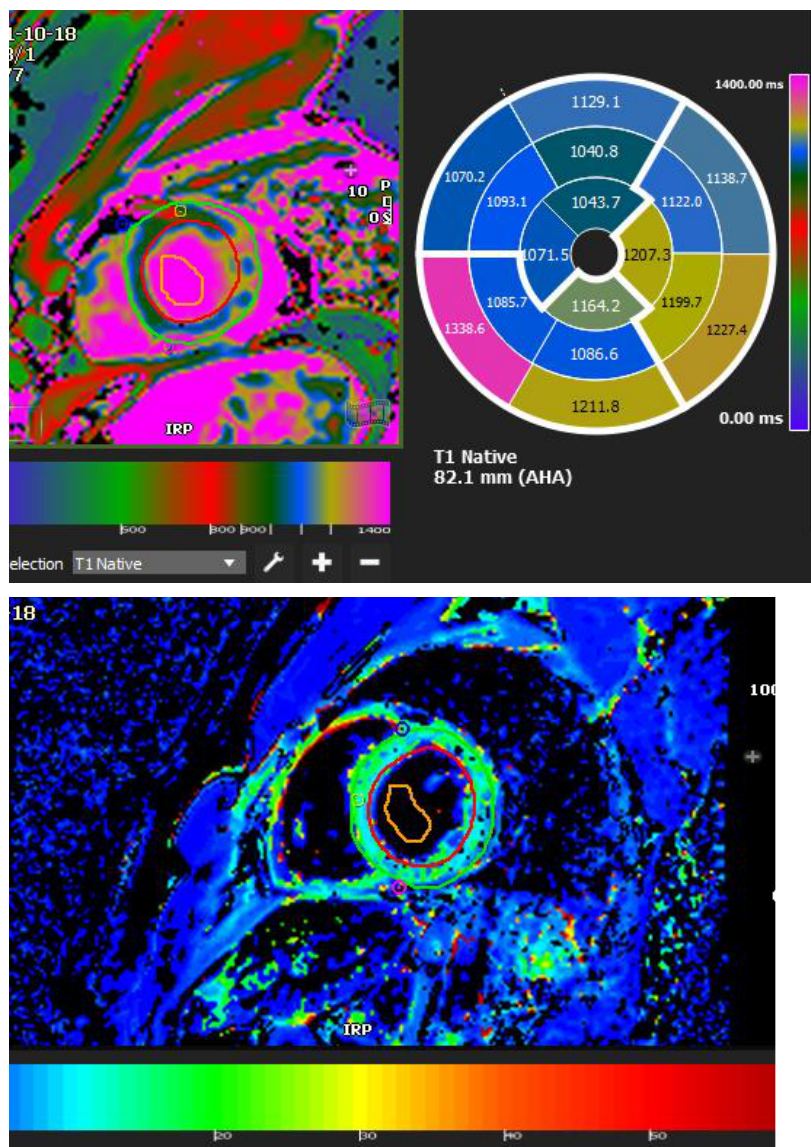
Figure 4. A 35-year-old male with a recent history of treated tuberculous pericarditis for six months had CMR for ventricular tachycardia. A native T1 map of 1132 ± 178 (Figure 4) and ECV of 25 ±